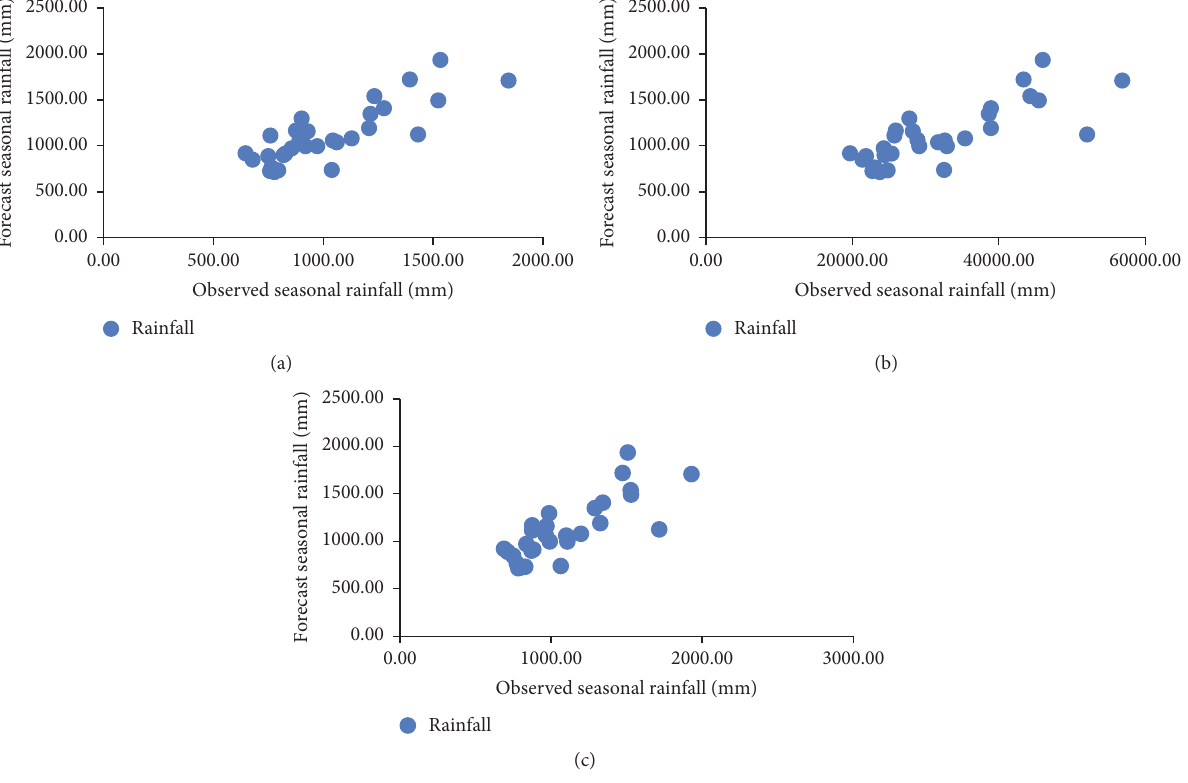
Figure 14: Scatter plot of observed (horizontal axis) and forecast (vertical) rainfall for (a) AM, (b) CAM, and (c)